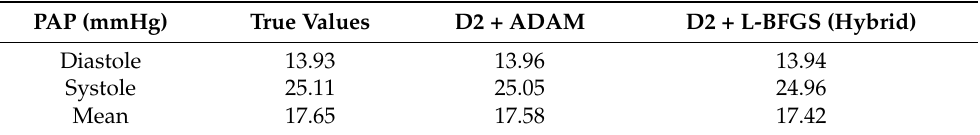
Table 5. Pulmonary pressure predictions for nominal model